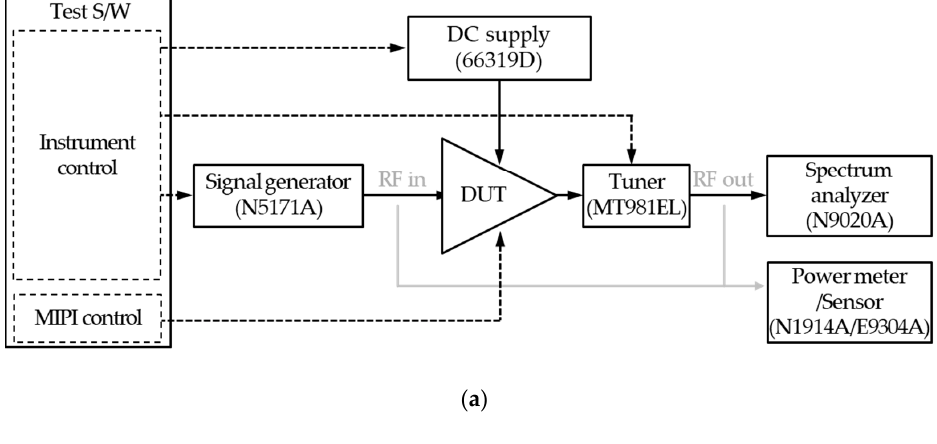
Figure 10. Measured output power comparison with and without protection circuit. (Frequency = 2017.5 MHz, collector voltage (Vcc) = 5.5 V, │ Γ L │ = 0.7).